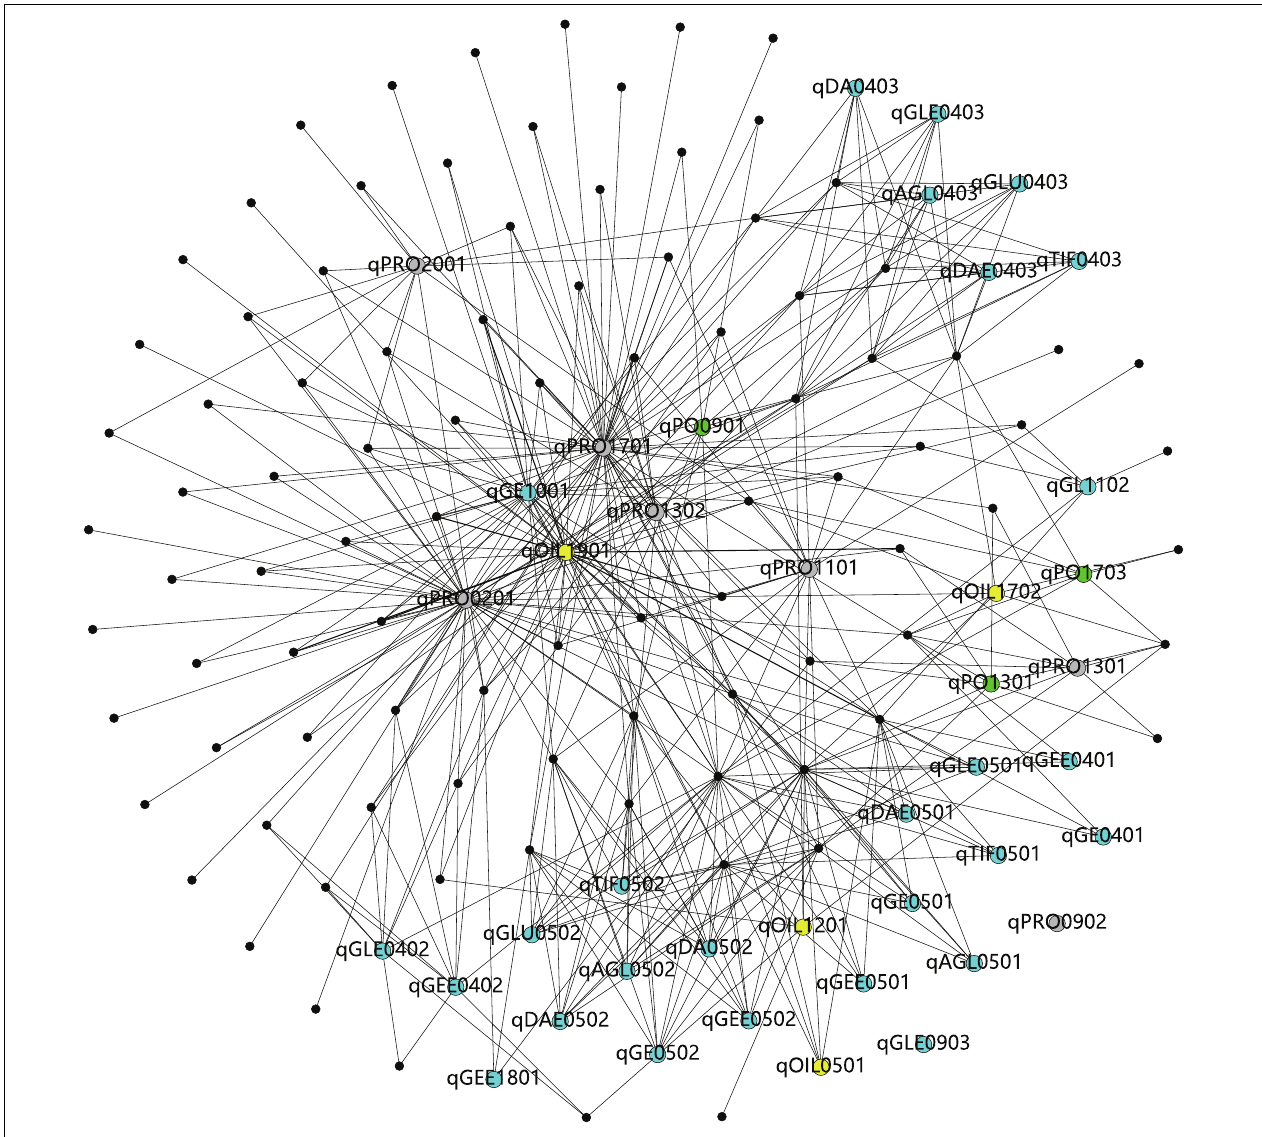
FIGURE 6 | The visualization of correlations between pathways and quantitative trait locus (QTL) (the black dots refer to pathways, the blue dots refer to the QTL associated with isoflavones, the gray dots present the QTL linked with protein, the yellow dots mean the QTL related to oil, and the green dots present to the QTL associated with protein plus